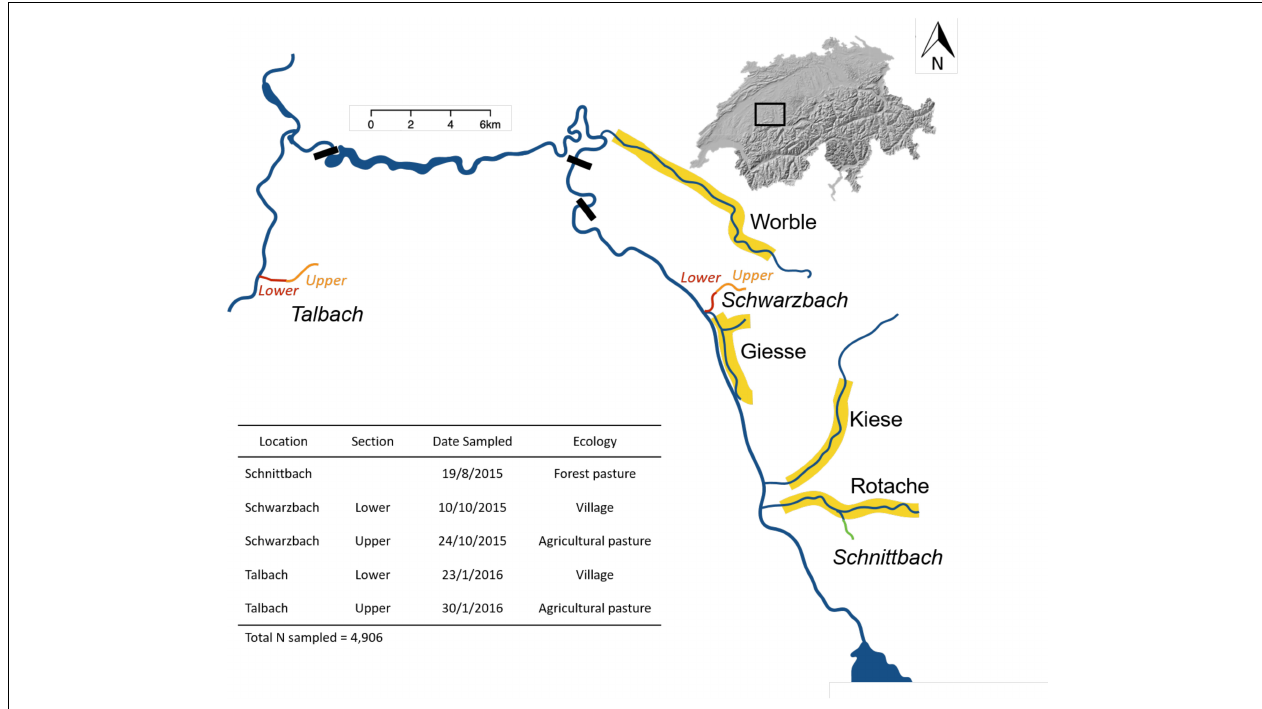
FIGURE 1 | Overview of the study area with the key stream locations used in the current study. Areas highlighted in yellow were the source populations of mature fish used for experimental breeding. Orange, red, and green colours represent stream locations stocked with hatchery-born fish and sampled for the field-based study. The ecology type of each of the latter stream locations is given in the